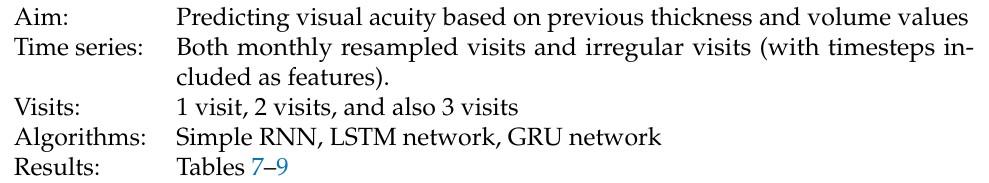
Table 4. Experiment 2 : Forecasting VA t + 1 from the numerical OCT features.